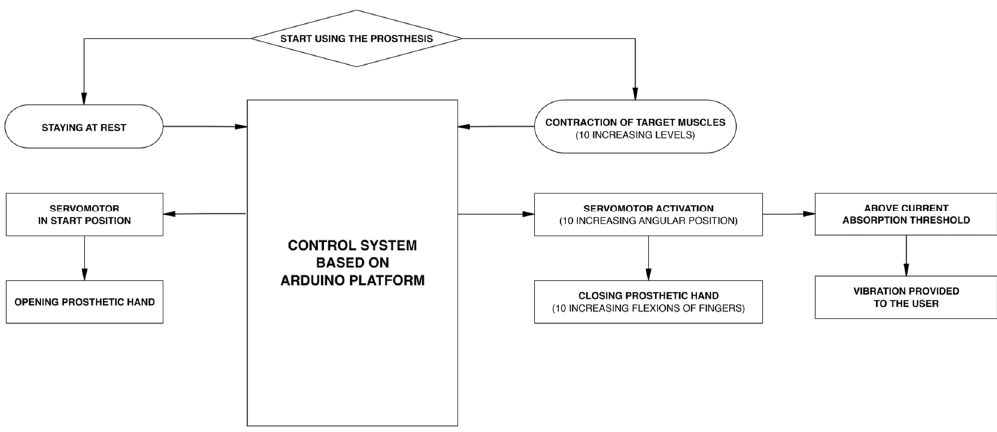
Figure 9. Flowchart describing the logic of the software implemented on the Arduino board.